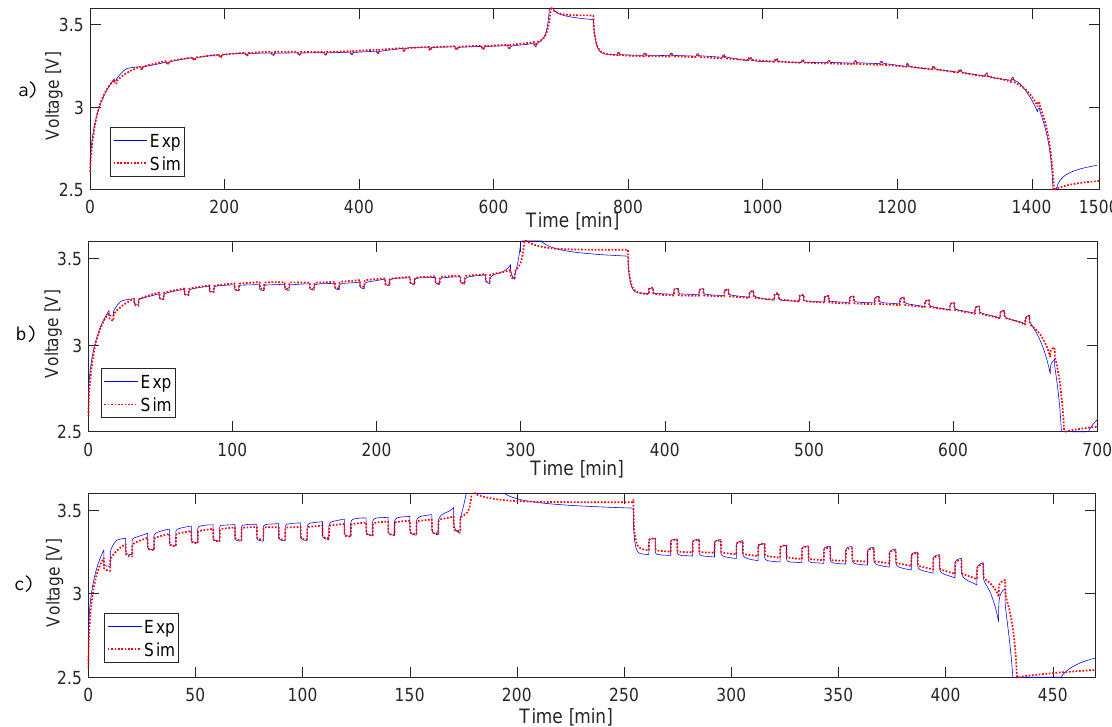
Figure 14. Comparison of experimental result and simulation result-LFP battery: ( a ) test with 0.1 C; ( b ) test with 0.25 C; and ( c ) test with 0.5